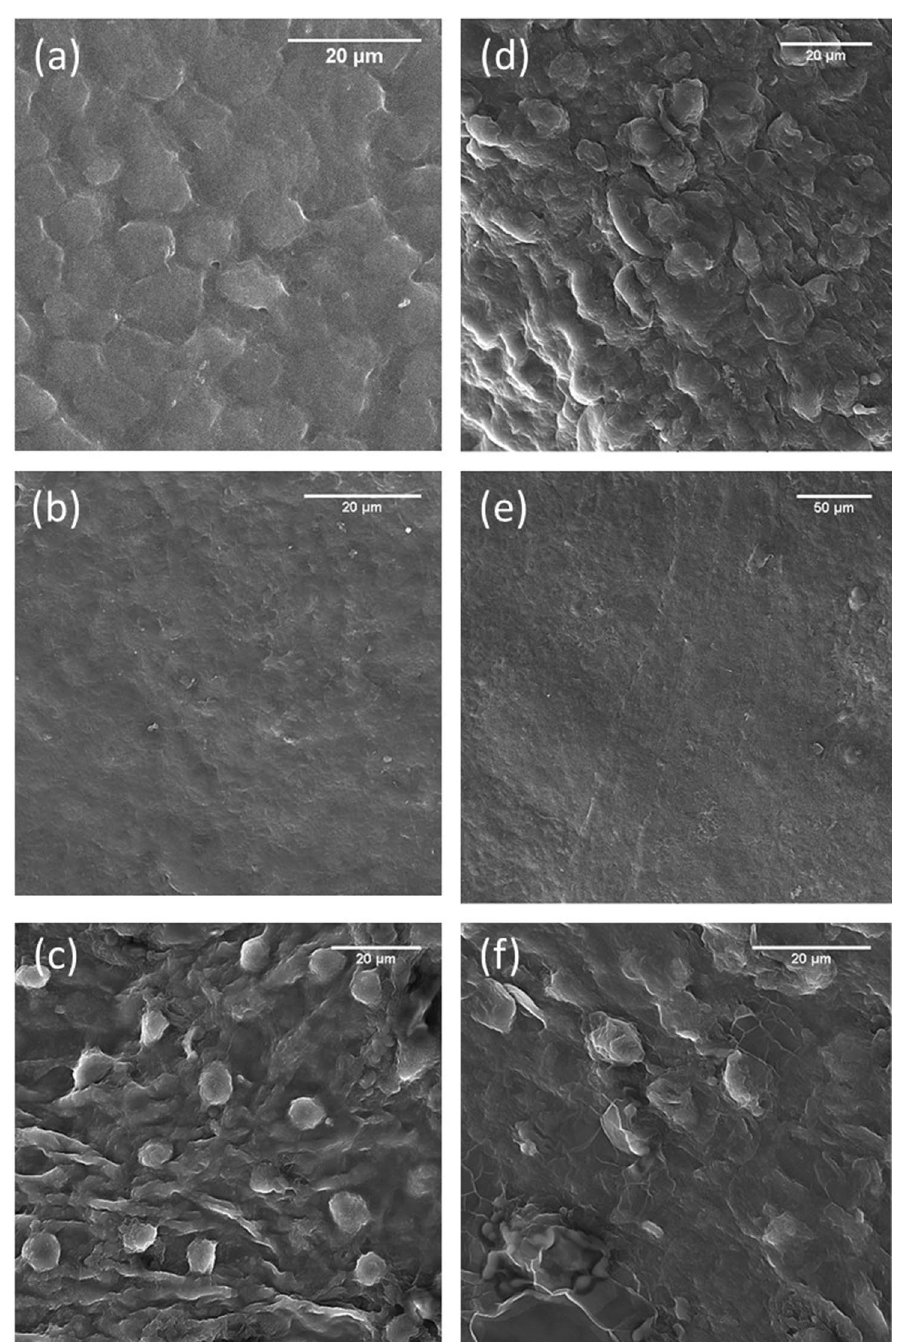
Figure 5. SEM images of dbACM before and after culturing HUVECs; ( a ) epithelial cells of amniotic membrane; ( b ) de-epithelialized amniotic membrane (basement membrane under the epithelial layer); ( c ) HUVECs on the amniotic side basement membrane of dbACM; ( d ) trophoblastic layer of chorion; ( e ) basement membrane under the trophoblastic layer after removing trophoblasts; ( f ) HUVECs on the chorionic side basement membrane of